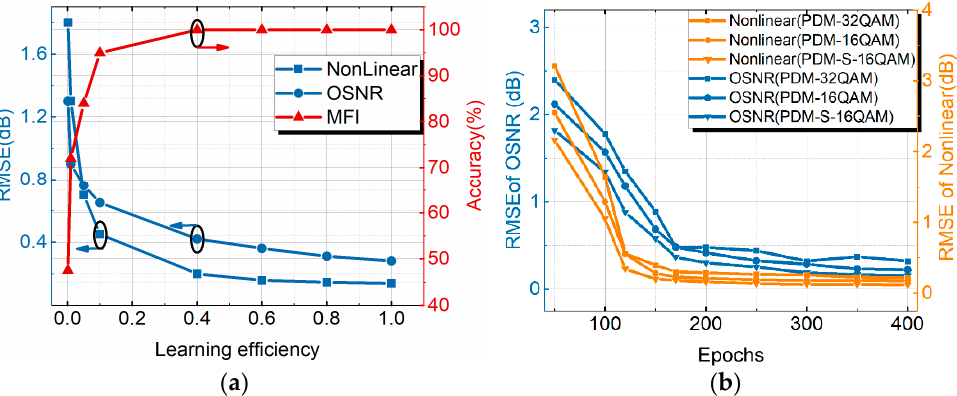
Figure 9. ( a ) Trend graph of learning efficiency with OPM (MFI, OSNR estimation and NL noise power estimation) results for PDM-32QAM system, ( b ) the trend of OPM with epochs for PDM-S- 16QAM, PDM-16QAM and PDM-32QAM. 16QAM, PDM-16QAM and